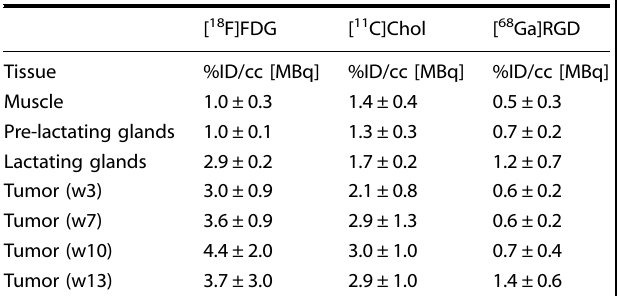
Table 1. Results of mean value